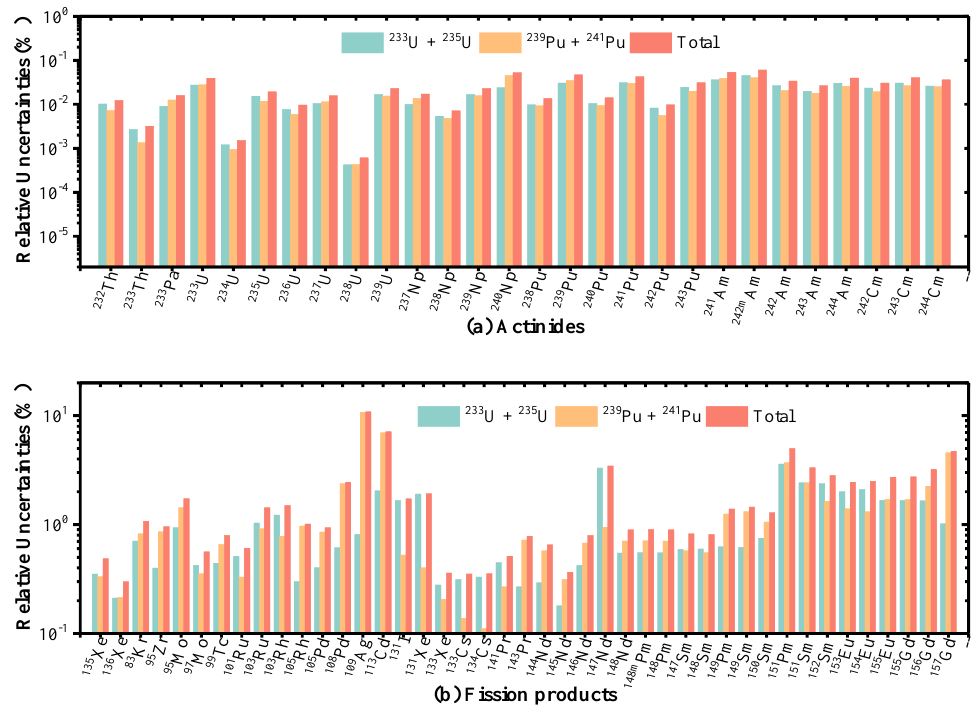
Figure 9. Uncertainties results from comparative and total uncertainty analysis. The contributions of fission product yield uncertainties from U and Pu to the nuclide density relative uncertainties have the same magnitude. Thus, the contribution of Pu fission product yield uncertainty to burnup uncertainty cannot be neglected. It should also be noticed, in total uncertainty analysis, that the nuclide density uncertainty of 109 Ag reaches 10.82%, which is the largest relative uncertainty among the nuclide densities. The above results also demonstrate that it is necessary to pay more attention to the impact of 239 Pu fission product yield uncertainty on burnup uncertainty in